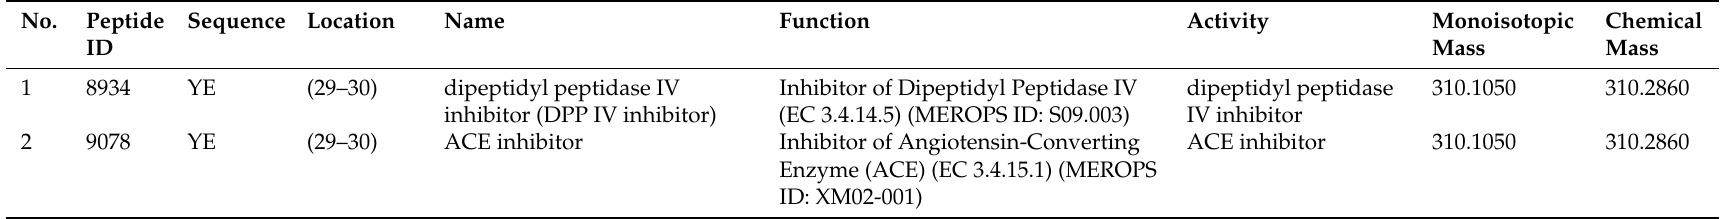
Table A13. Bioactive peptides from RubisCO of Halophila stipulacea . In silico enzymatic cleavage was carried out by using